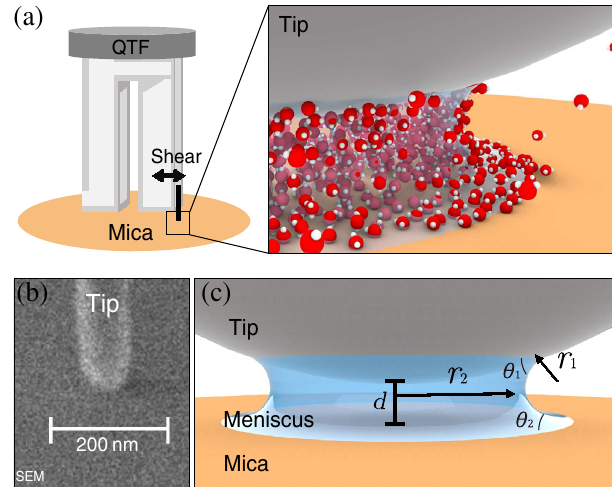
FIG. 1. (a) Experimental scheme of shear-mode quartz-tuning- fork – based (QTF-based) AFM. The inset shows the artistic view of the water meniscus having a highly negative curvature at molecular scale. (b) Typical scanning electron microscopic (SEM) image of a quartz tip with radius of about 40 nm that is glued to one of the QTF prongs. (c) Geometry of the water meniscus. The liquid-vapor interface of the meniscus is in mechanical equilibrium by having the constant mean curvature. Here, r 1 and r 2 are the two principal radii-of-curvature ( r 1 ∼ − 1 nm is negative and r 2 ∼ 10 nm positive in ambient condition) and d is the tip-surface distance. Here, θ 1 and θ 2 are the contact